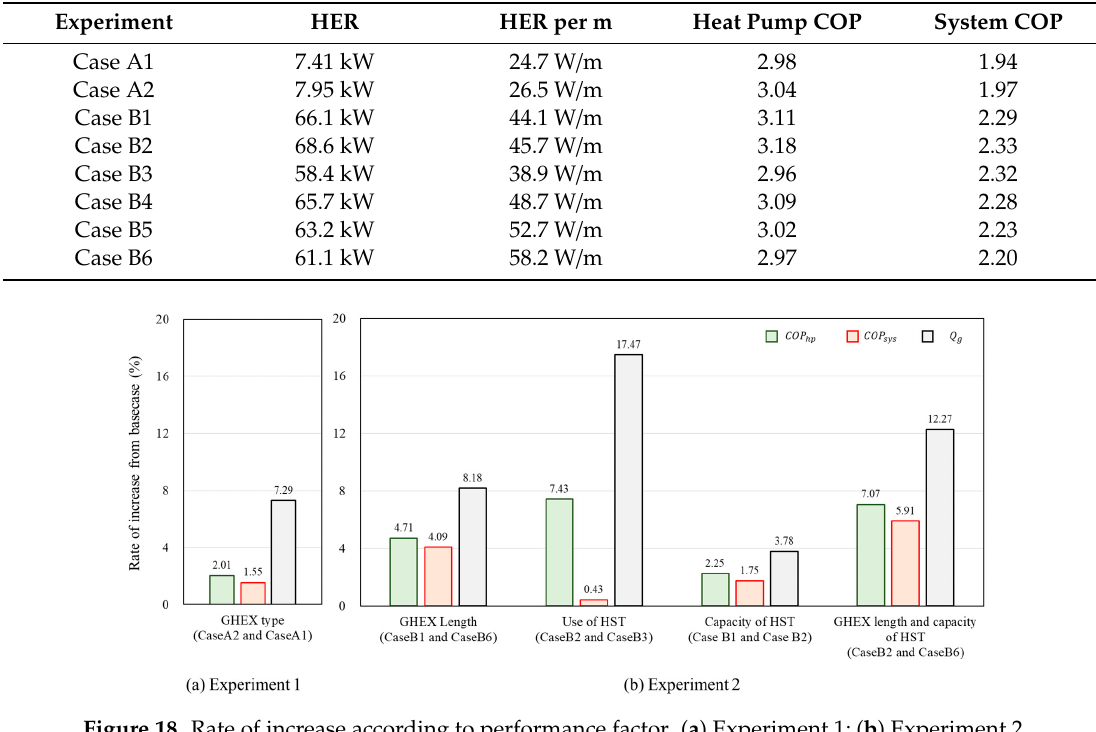
Figure 18. Rate of increase according to performance factor. ( a )Experiment 1; ( b )Experiment 2.